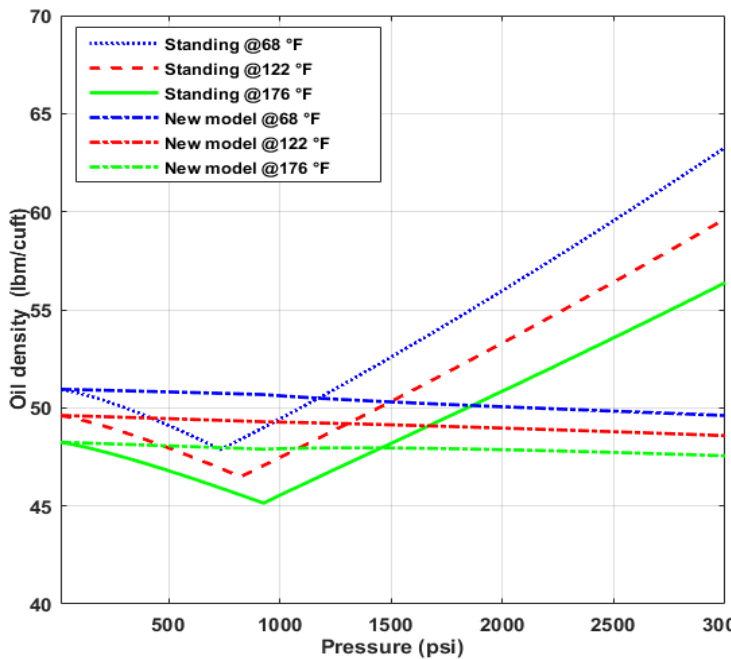
Figure 6. Oil density as a function of Black oil and the new correlations.